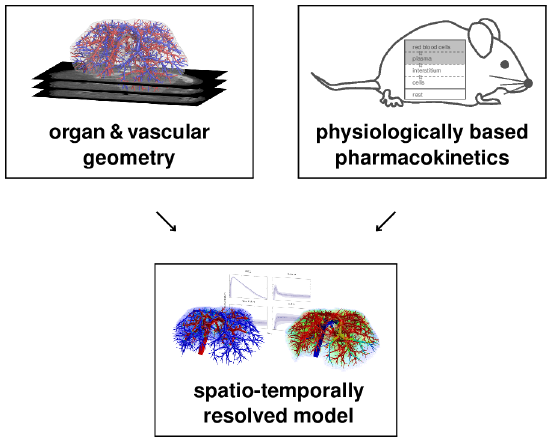
Figure 1. Conceptual model overview. Our spatially resolved model is based on mass balance equations from physiologically based pharmacokinetic modeling as well as organ and vascular geometry obtained by in vivo imaging. The combined model allows a detailed simulation of hepatic distribution and metabolization to accurately describe spatio-temporal effects underlying first-pass perfusion in the liver.